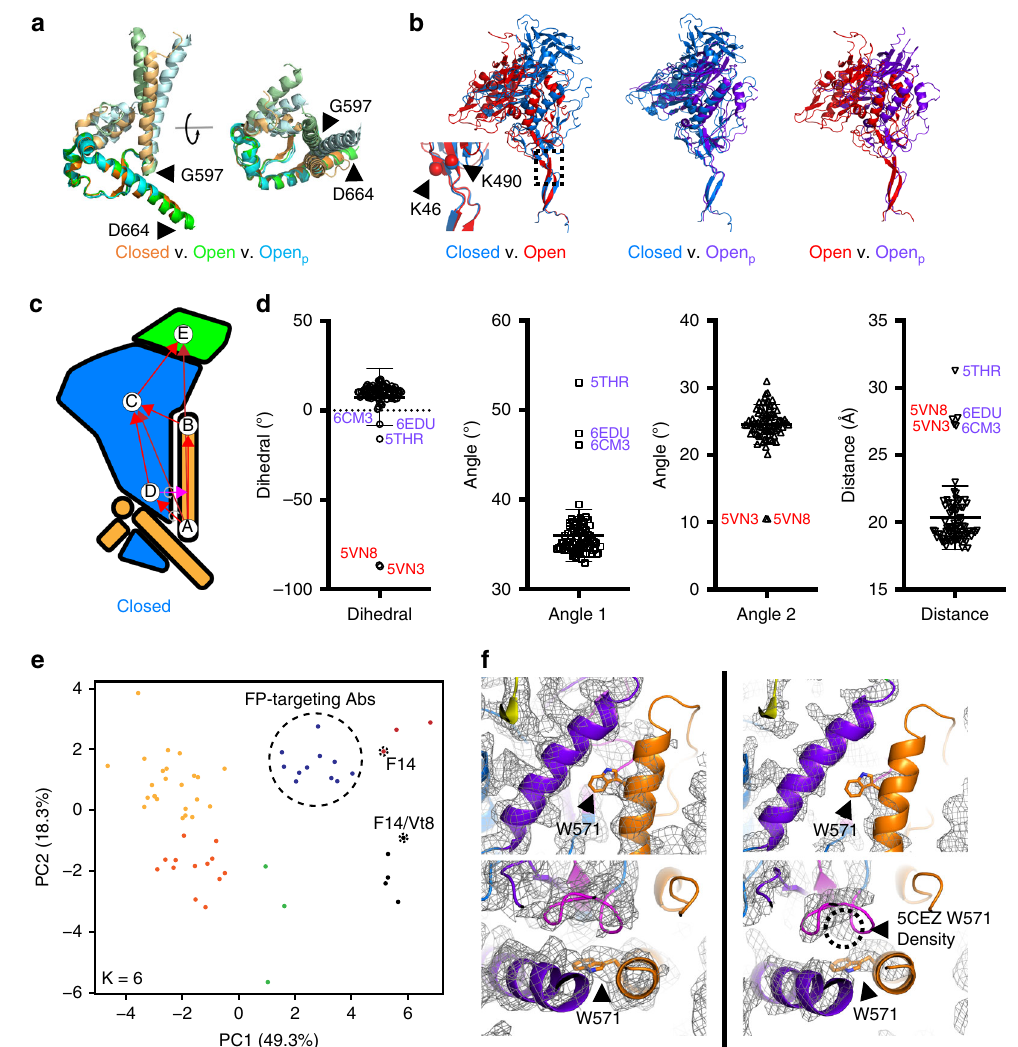
Fig. 5 Domain organization and antigenicity of the BG505 F14 and BG505 F14/Vt8 SOSIP. a Alignment of gp41 residues 597 to 664 in the closed (PDB ID 5CEZ), partially open (Open p ; PDB IDs 6CM3 and 6EDU), and open (PDB IDs 5VN3 and 5VN8) SOSIP trimers. b Relative orientations of gp120 in the closed (PDB ID 5CEZ), partially open (PDB IDs 6CM3), and open (PDB IDs 5VN3) SOSIP trimers aligned on gp41 residues 597 to 664. (inset, left) Relative gp120 orientations from the gp41 597 to 664 residue alignment depicting the location of the K46/K490 hinge-point. Note: the color coding for the SOSIPs here differs from that in panel a . c Cartoon representations of gp120 (light blue), gp120 V1/V2 region (green), and gp41 (yellow) in the closed state. Letters indicate location of centroids with arrows depicting vectors between centroids. d (left) BADC dihedral angles for closed, partially open, and open state structures. (middle left) BAD angles for closed, partially open, and open state structures. (middle right) ADC angles for closed, partially open, and open state structures. (right) BC vector magnitudes for closed, partially open, and open state structures. Open state structures (PDB IDs 5VN8 and 5VN3) are marked with red labels, and partially open structures (PDB IDs 6CM3, 6Edu and 5THR) are shown with purple labels. Error bars represent the standard deviation of the mean. e Principal components analysis of centroid vectors with principal component one and two scores plotted for each closed state SOSIP analyzed. Points are colored according to k-means clusters ( K = 6; associated PDB IDs: Supplementary Table 5). f (left) Alignment of the BG505 F14/Vt8 coordinates with the vFP7.04 bound BG505 DS SOSIP cryo-EM map (EMD-7621). (right) Alignment of the BG505 F14/Vt8 coordinates with the PDB ID 5CEZ map. W571 (sticks) aligns with density corresponding to 5CEZ V570